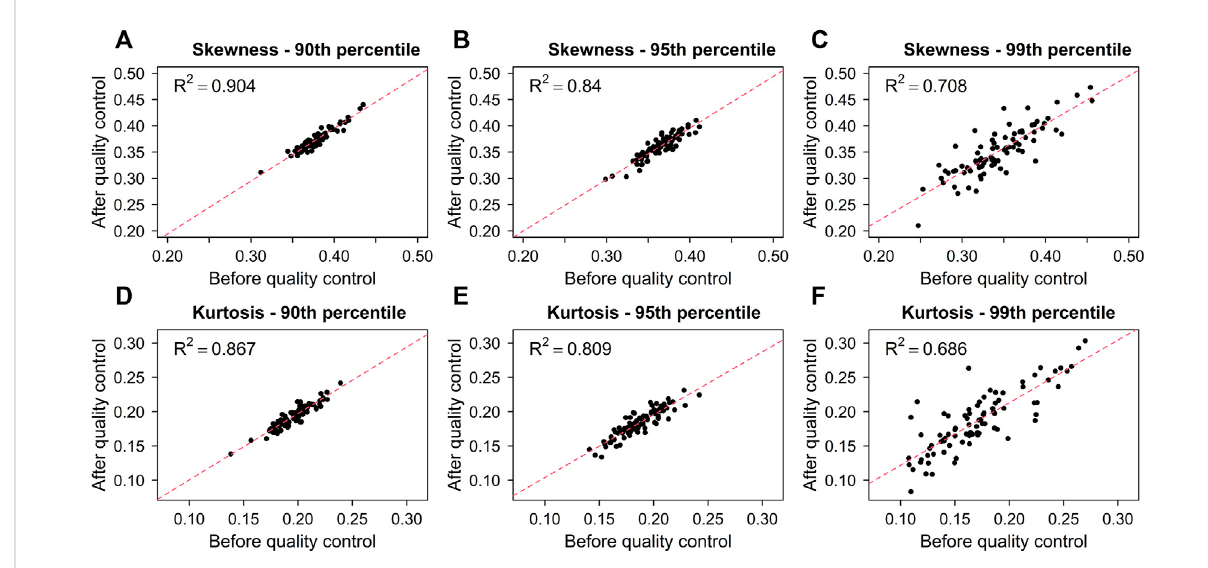
FIGURE 2 RelationshipbetweentheL-coef fi cientsofskewness (A-C) andkurtosis (D-E) inthepartialdurationseriesatthe90th,95thand99thpercentiles before and after quality control process from 1974 to 2018. The red dashed line represents the simple linear